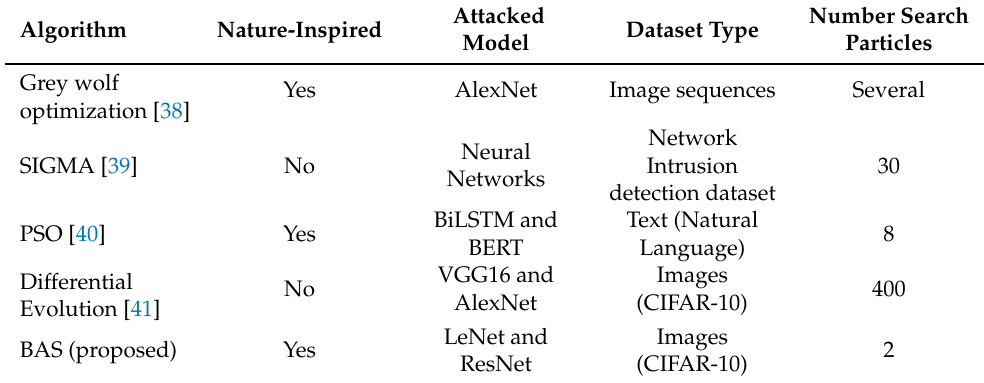
Table 1. Comparison between metaheuristic algorithms proposed in the literature for fooling Neural Network